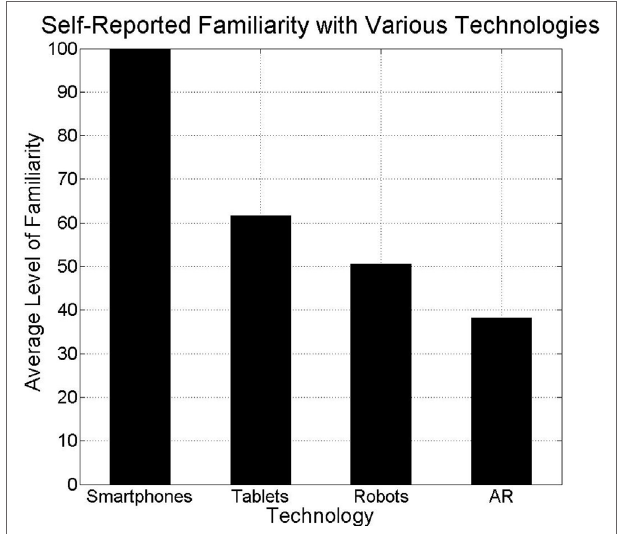
FigUre 9 | The average levels of familiarity with various emerging technologies reported by participants